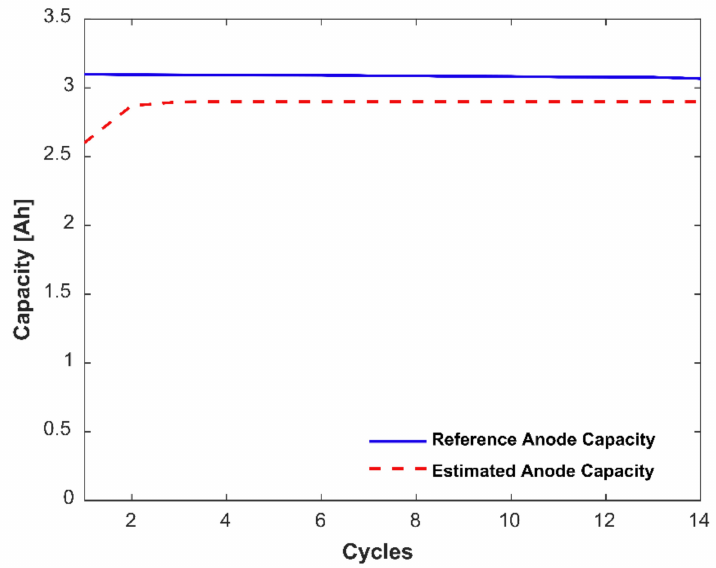
Figure 13. Comparison between estimated anode capacity (red dashed) and the reference anode capacity from [1] (blue) for standard CCCV charging profile for a single three-electrode